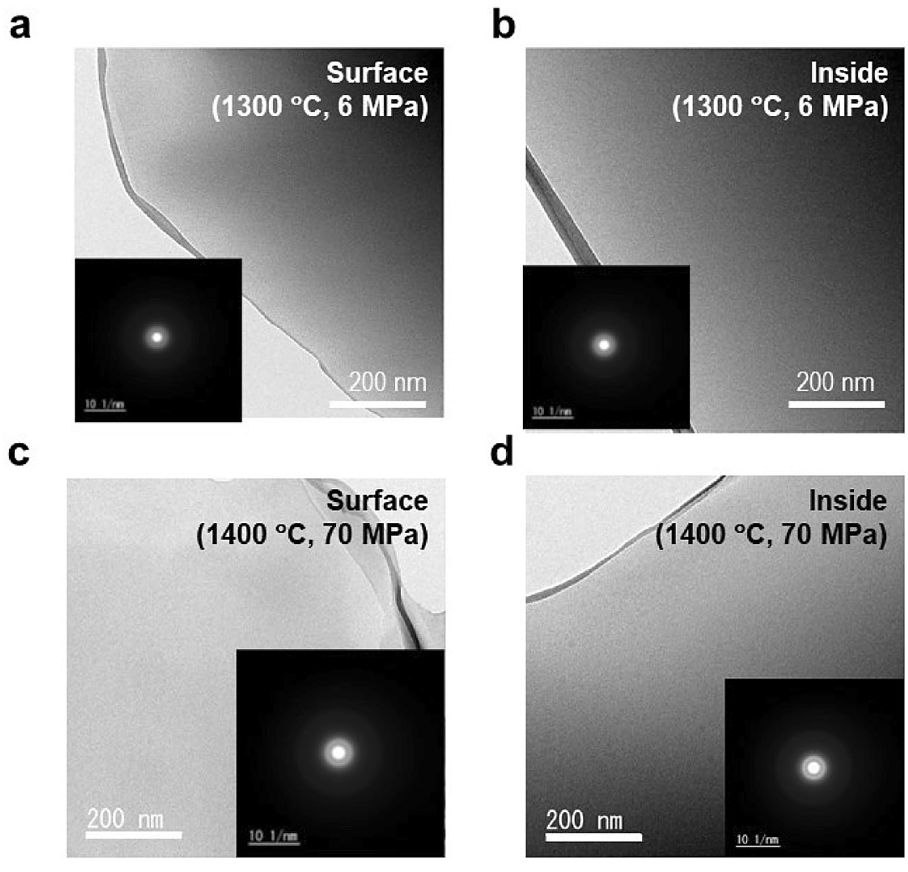
Figure 4. TEM observation of SPS-SiO 2 glasses. TEM images of the ( a , c ) surfaces and ( b , d ) insides of the SPS- SiO